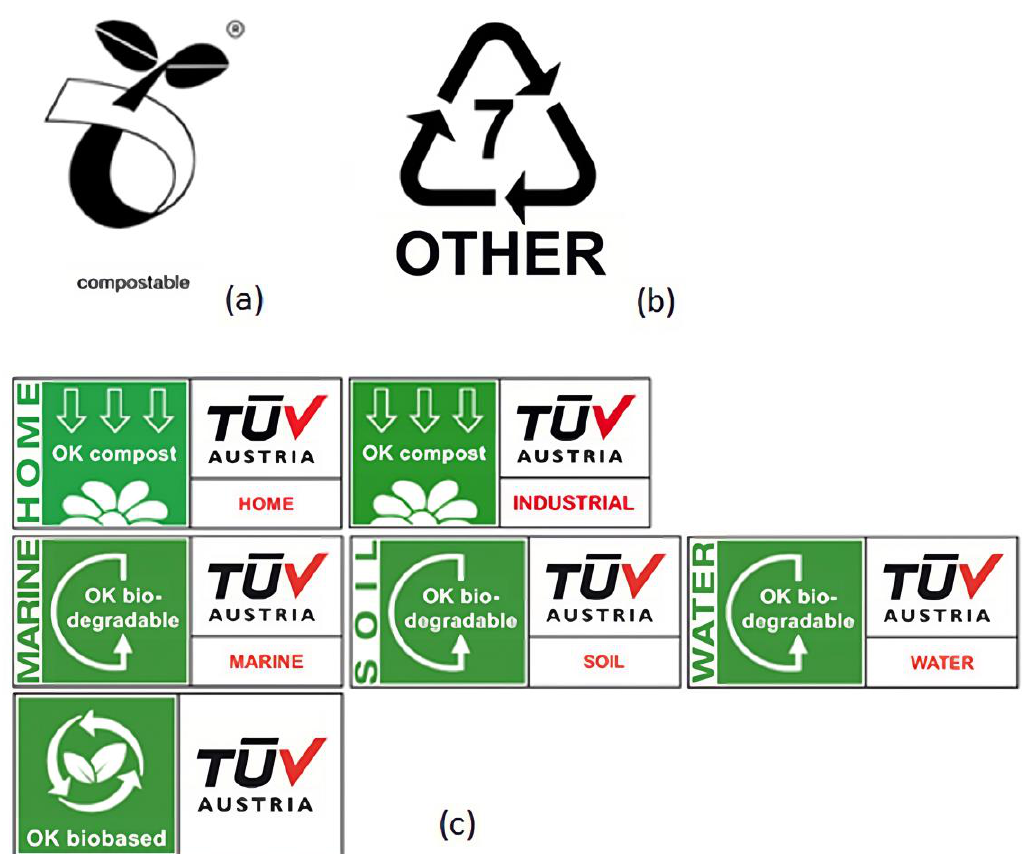
Figure 21. Labels currently used as compost, biobased and biodegradable polymers by European Bioplastics ( a ), ASTM International ( b ) and the Vinçotte/TÜV AUSTRIA Group ( c ) [32,73,81].